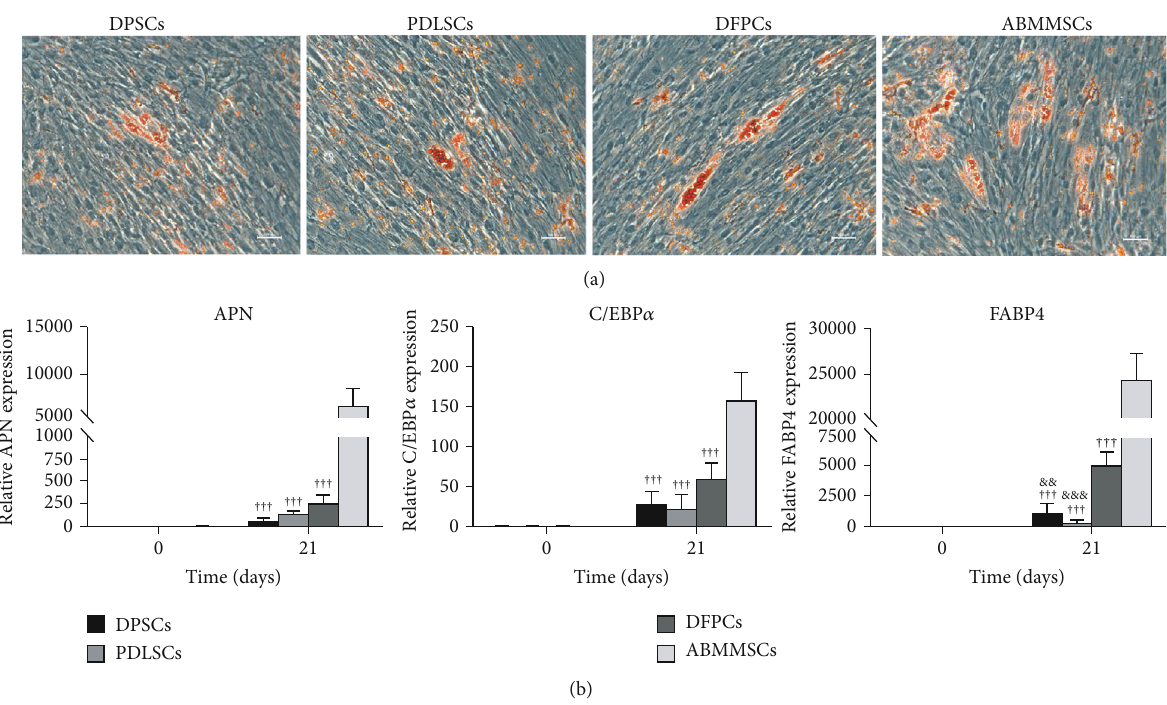
Figure 6: Adipogenic di ff erentiation capacity of DPSCs, PDLSCs, DFPCs, and ABMMSCs. (a) Oil red O staining of DPSCs, PDLSCs, DFPCs, and ABMMSCs after 21 days of adipogenic di ff erentiation ( scale bar = 500 μ m). (b) qRT-PCR was performed to analyze the potency of adipogenic di ff erentiation in DPSCs, PDLSCs, DFPCs, and ABMMSCs at days 0 and 21. The y -axis represents the relative mRNA fold change, which was calculated using the 2 − ΔΔ Ct formula with β -actin as the internal control. Error bars represent the SD ( n = 3 ) ( ∗ p < 0 : 05 , ∗∗ p < 0 : 01 , and ∗∗∗ p < 0 : 001 vs. DPSCs; # p < 0 : 05 , ## p < 0 : 01 , and ### p < 0 : 001 vs. PDLSCs; & p < 0 : 05 ; && p < 0 : 01 , and &&& p < 0 : 001